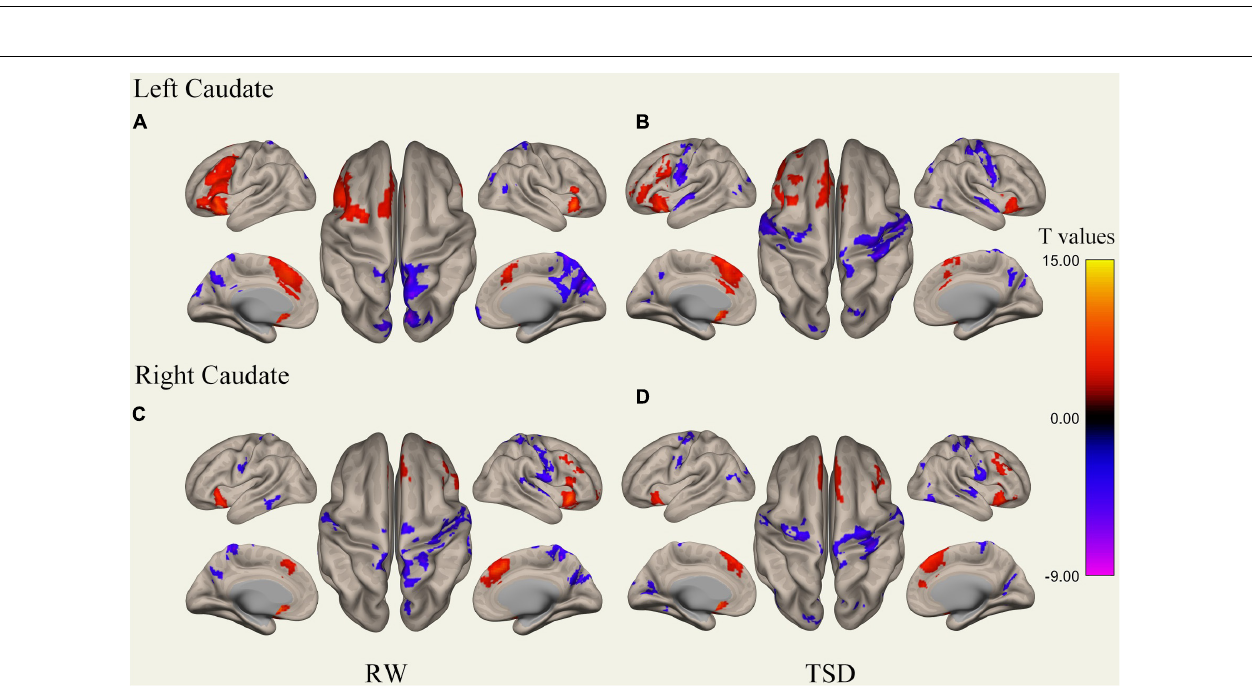
FIGURE 4 | Whole-brain functional connectivity patterns of the caudate before 36 h TSD shown at panels (A,C) , and after 36 h TSD shown at panels (B,D) ( n = 30) (Surface view). Warm colors indicate positive correlations, and cold colors indicate negative correlations.